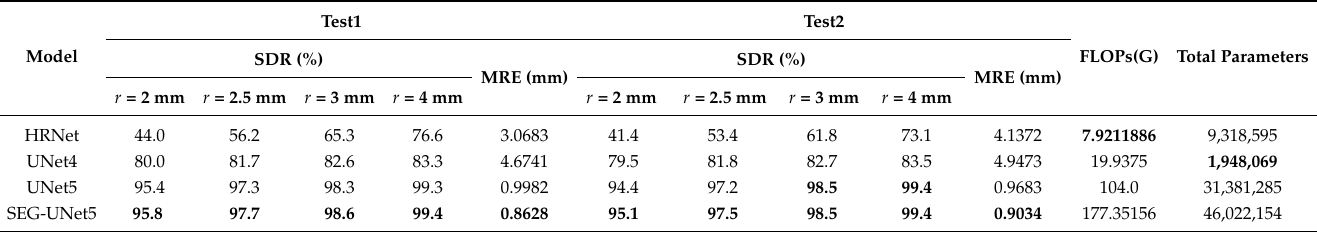
Table 1. 2D hand radiograph dataset: The comparison results for our proposed improving-teacher method on the 2D hand radiograph dataset. The student model is UNet4, while the teacher model is UNet5 and SEG-UNet5. We have bolded the data with the best results.